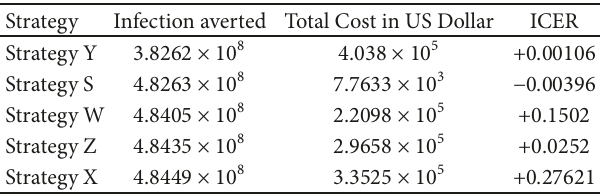
Table 2: The arrangement of the strategies in ascending order of the total infection averted.